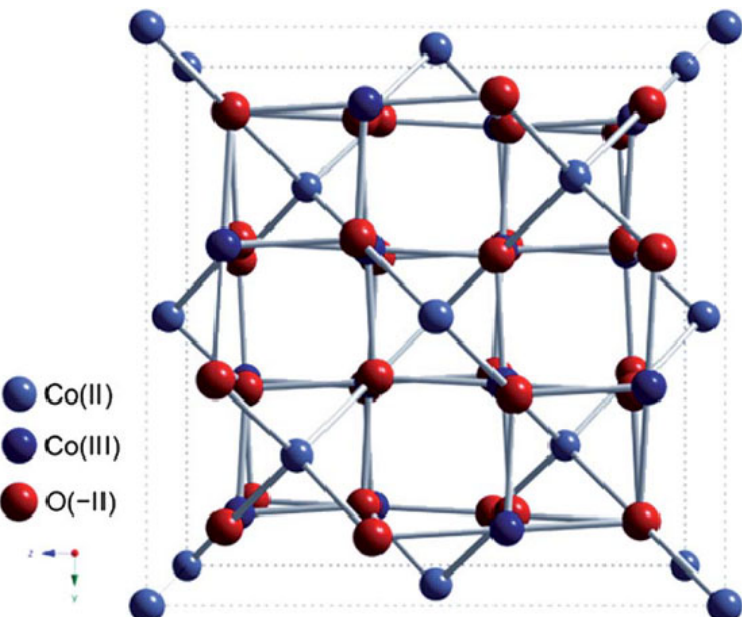
Figure 3. Scheme of the spinel structure of cobalt(II,III) oxide. Reprinted with permission from Ref. [58]. Copyright 2012 Royal Society of Chemistry.